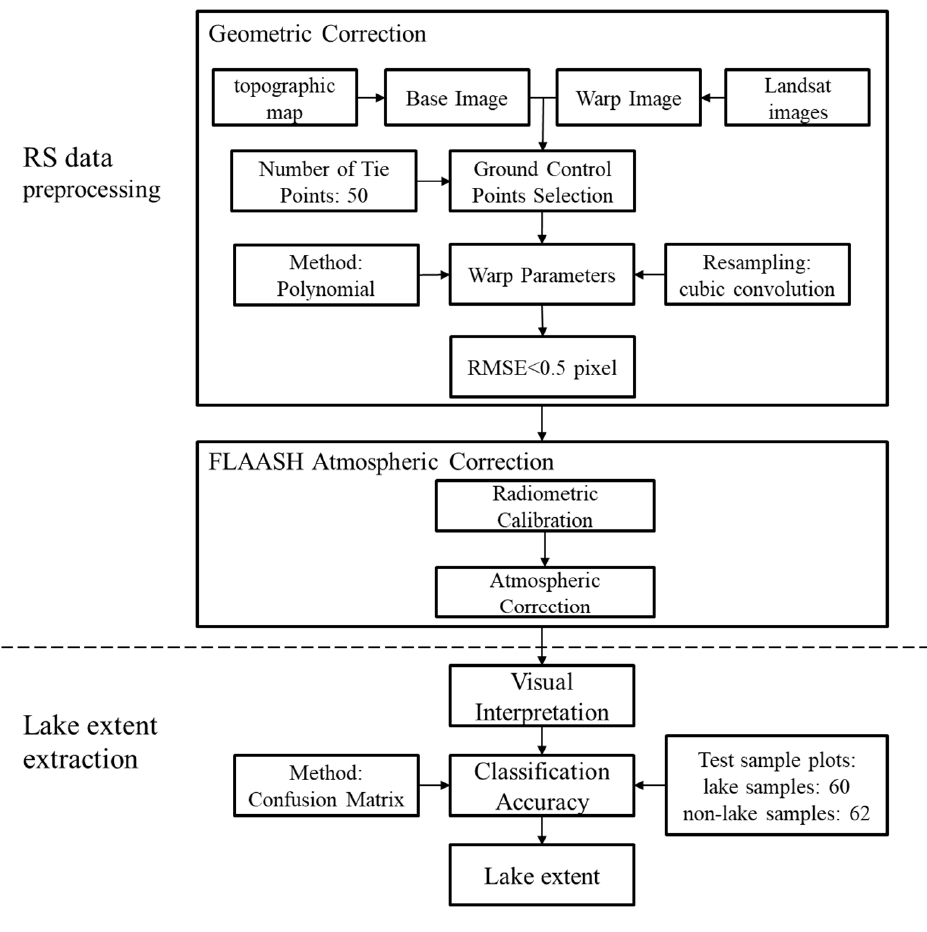
Figure 2. Workflow of lake area mapping.